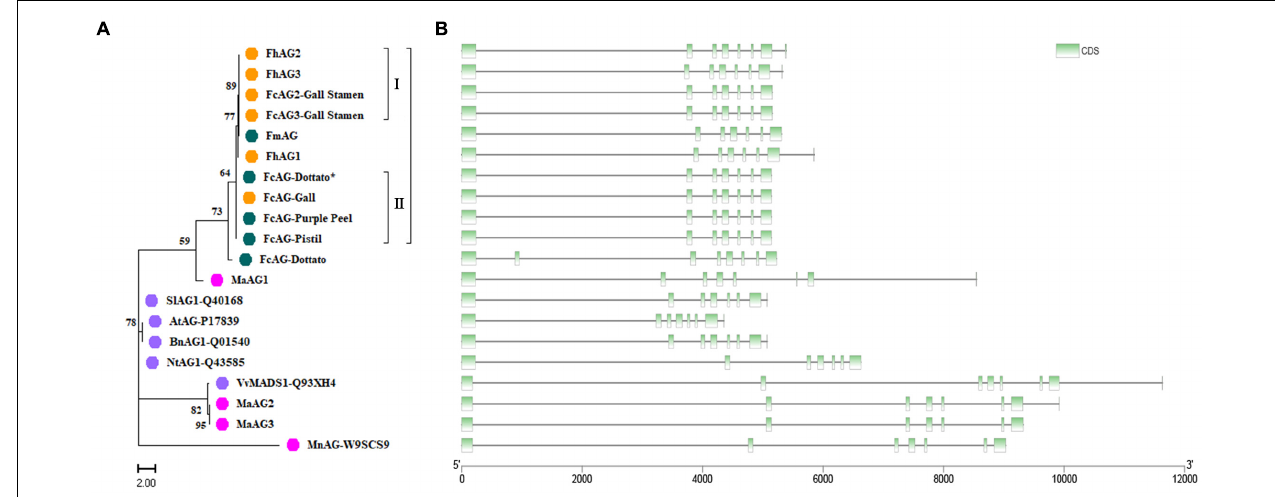
FIGURE 2 | Cluster analysis of AG genes and their encoded proteins from various species. (A) Phylogenetic tree. Orange – Ficus males; green – Ficus females; pink – Moraceae plants; purple – other plant species. (B) Gene structure. Each gene in panel B corresponds to the protein to its left in panel A . Green – coding sequence (CDS); black line –